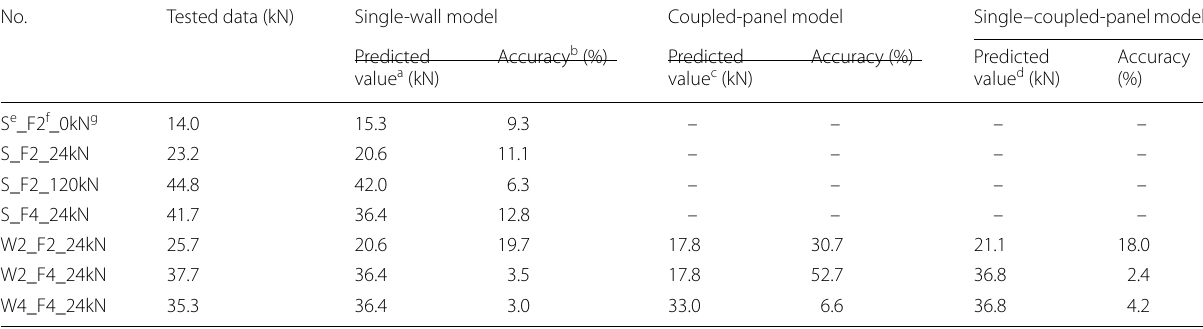
Table 4 Lateral resistances by experimental test and by prediction